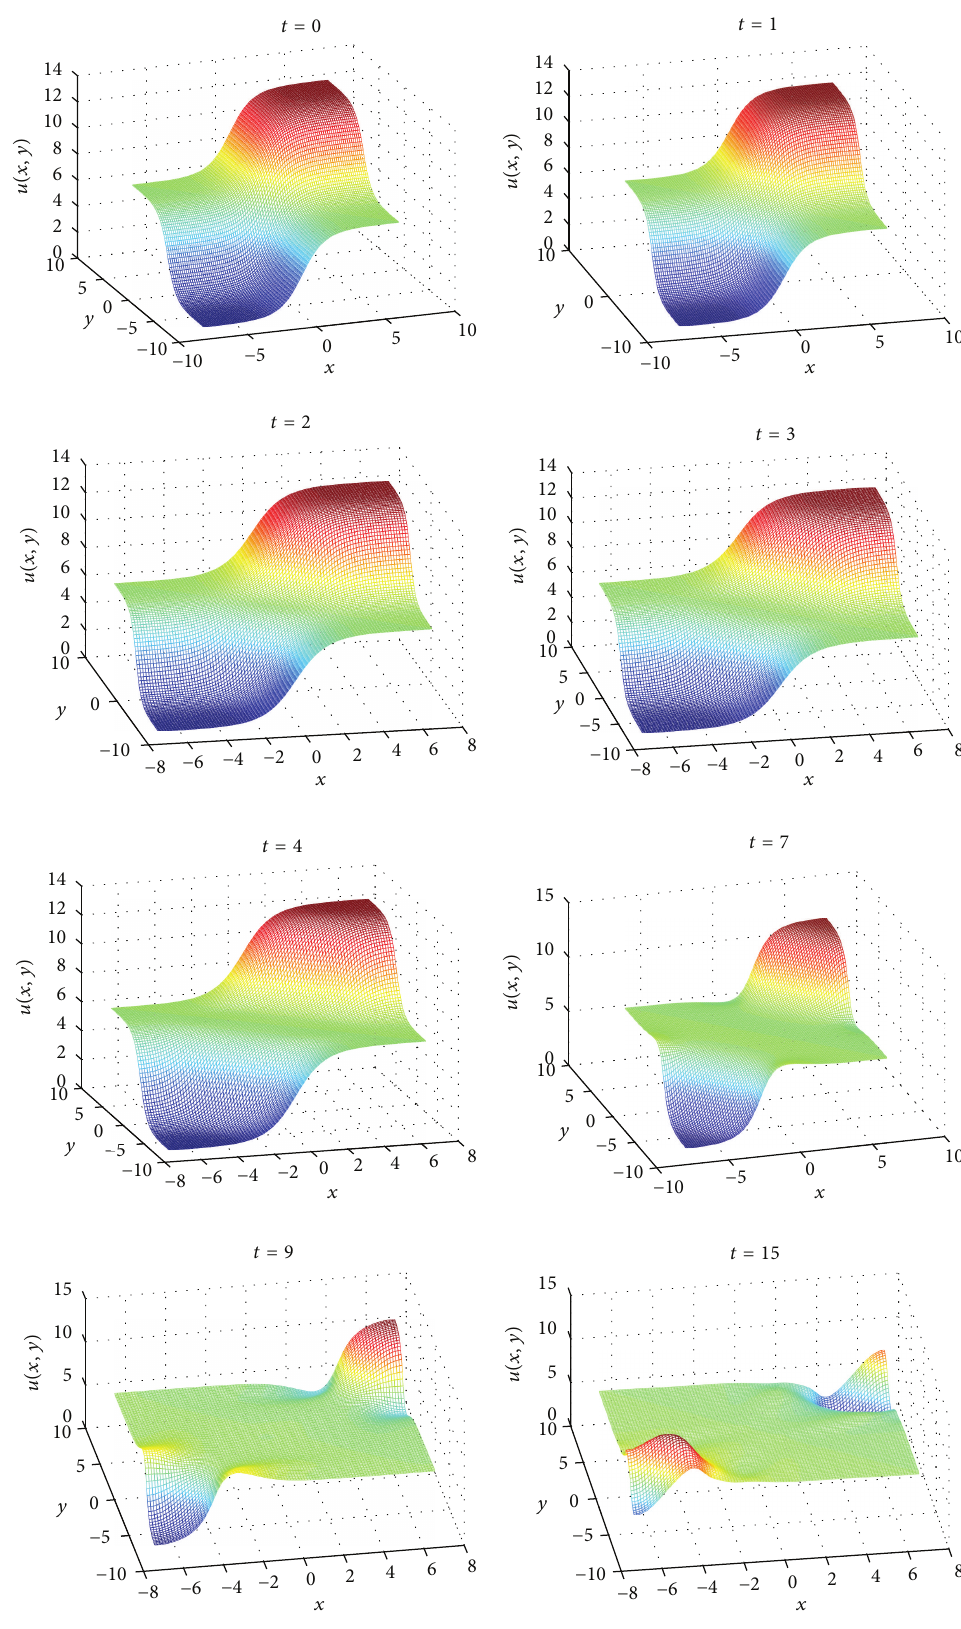
Figure 3: The numerical solutions at times 𝑡 = 0, 1, 2,3, 4, 7, 9,15 for superposition of two line